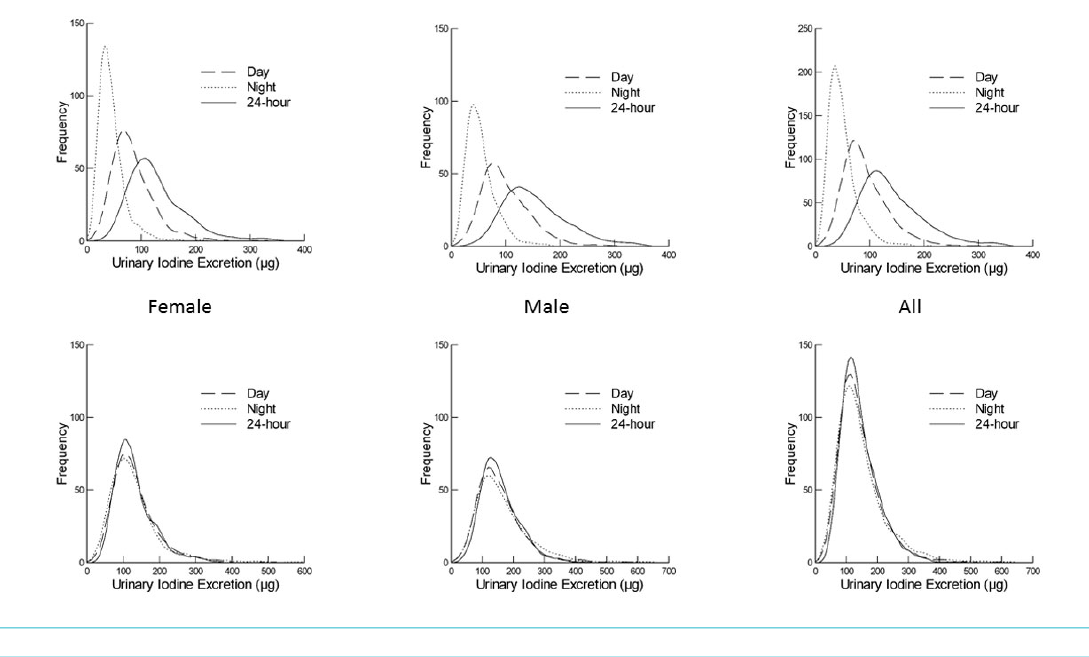
Figure 1: Comparison of measured urinary iodine excretion (UIE) vs day-time:24-hour and night-time:24-hour normalised UIE. Top row: mea- sured day-time, night-time and 24-hour UIEs for the female (left), male (centre) and entire (right) study population. Bottom row: distributions of